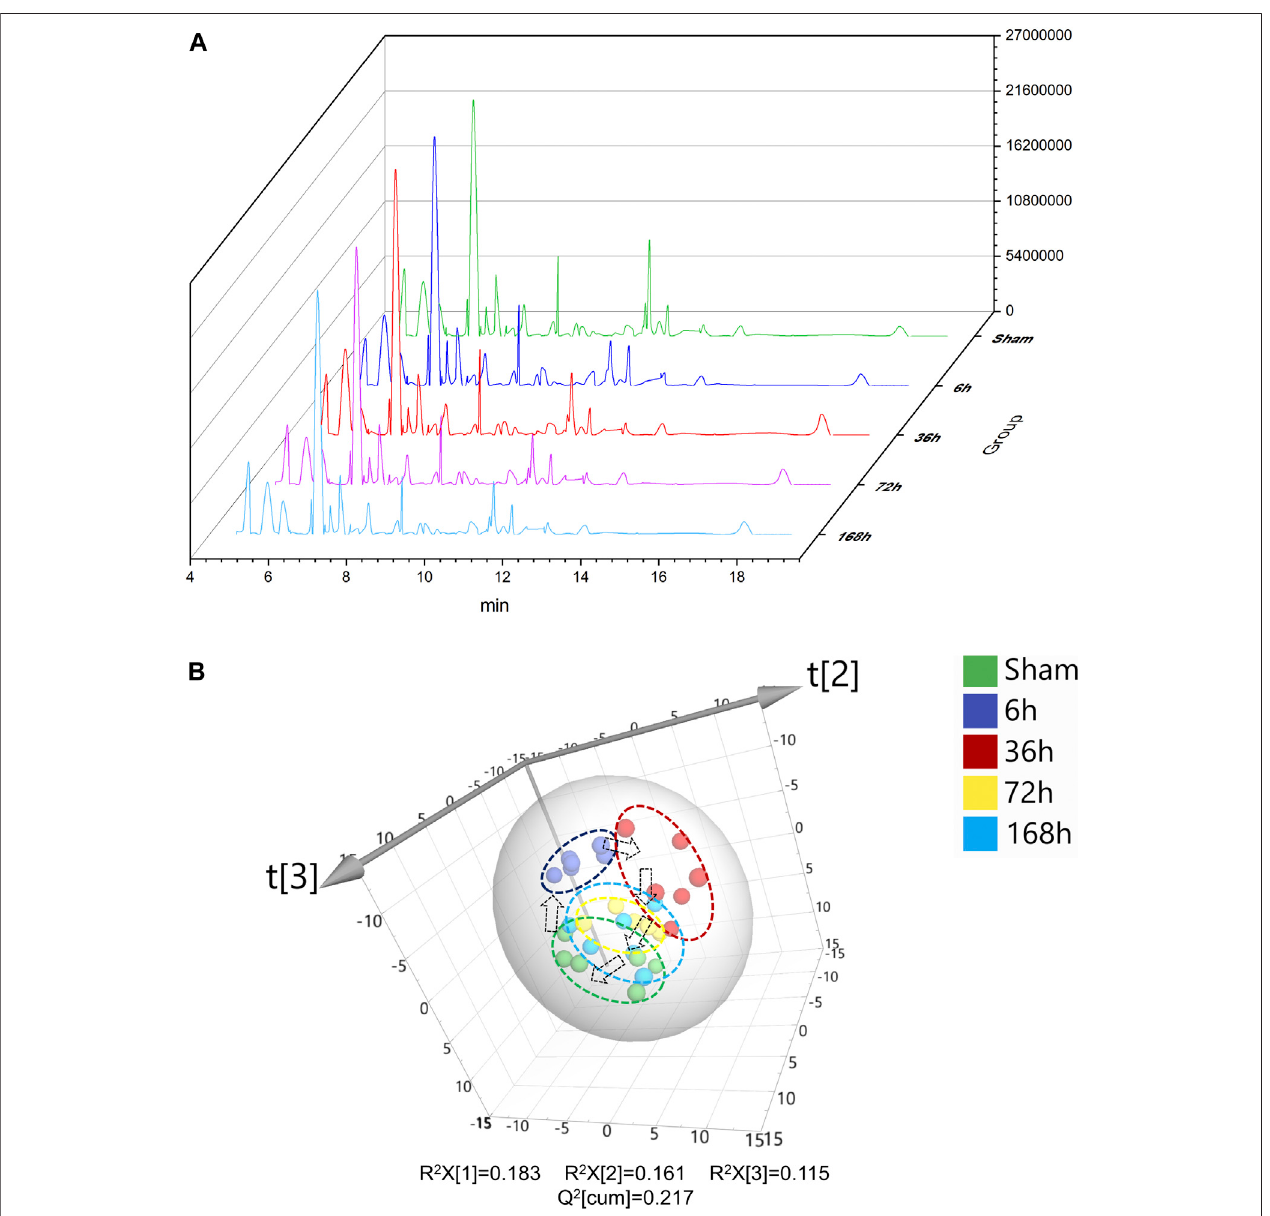
FIGURE 2 | (A) Typical GC/MS chromatograms of serum from Sham group and 6, 36, 72, and 168 h after PHx. (B) 3D scoress plot of principal components analysis of mouse serum from Sham group, 6 h group, 36 h group, 72 h group, and 168 h group, respectively. Each point represents a metabolite pro fi le of a biological